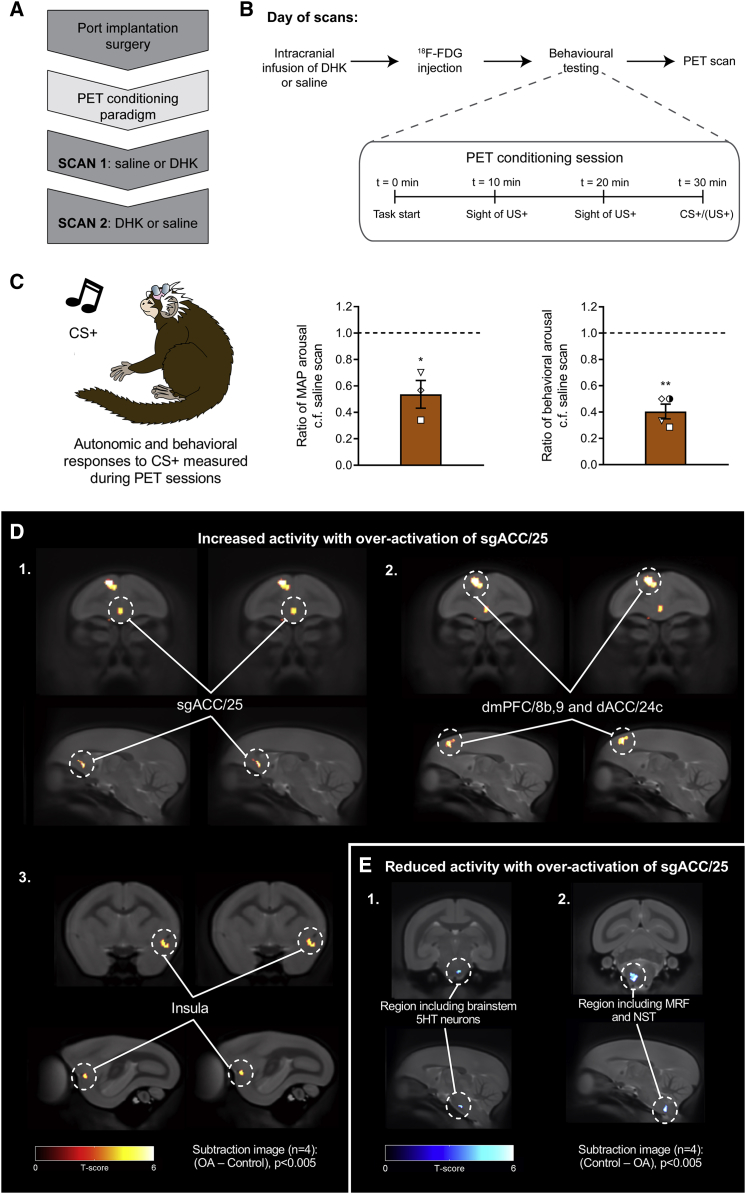
18F-FDG PET Imaging Revealed Metabolic Changes in a Network of Brain Regions Associated with Reward Processing and Interoception Following sgACC/25 Over-ActivationRelevant graphs show mean ± SEM (n = 3 for cardiovascular arousal; n = 4 for behavioral arousal). n = 4 for all PET images; clusters discussed are significant at the level of p < 0.005 with an extent threshold adjusted for search volume of 26 voxels.(A) Following implantation of a subcutaneous port into the internal jugular vein, marmosets were trained on a modified version of the appetitive Pavlovian conditioning paradigm (see B) in preparation for scanning. Saline control and DHK scans were counterbalanced.(B) On the day of a scan, animals received an infusion of DHK or saline immediately followed by 18F-FDG injection through the port. The PET conditioning session (inset) lasted 30 min (to increase the sensitivity of 18F-FDG uptake to perturbation by the behavioral paradigm), consisting of two 20 s periods of the sight of reward without access, and a final 20 s CS+ period. During training, the CS+ was followed by a 120 s US+. On scan days, the animals were immediately removed from the apparatus when the CS+ period terminated, anesthetized, and then scanned.(C) Cardiovascular and behavioral responses were measured during the CS+ period in the PET conditioning sessions immediately prior to scanning. Compared to saline scans, over-activation of sgACC/25 significantly blunted cardiovascular (ratio of MAP response to saline scans; one-sample t test to 1.0, p = 0.048) and behavioral (ratio of head-jerk response to saline scans; one sample t test to 1.0, p < 0.001) arousal.(D) Subtraction images calculated from standardized uptake value ratio (SUVR) maps for over-activation (OA) scans—saline control scans, showing brain regions with increased activity following sgACC/25 over-activation. Increased metabolic activity was observed in sgACC/25 (1), together with a region of dorsomedial prefrontal cortex spanning dmPFC/8b,9 and dACC/24c (surviving p < 0.001; 2). More caudally, increased metabolic activity was observed in the left ventral insula (3).(E) Subtraction images calculated from SUVR maps for saline control scans—over-activation scans, showing brain regions with reduced activity following sgACC/25 over-activation. Reduced metabolic activity was observed in a region encompassing brainstem 5HT neurons (1) and, more caudally, brainstem autonomic control centers including the medullary reticular formation (MRF) and the nucleus of the solitary tract (NST; 2).